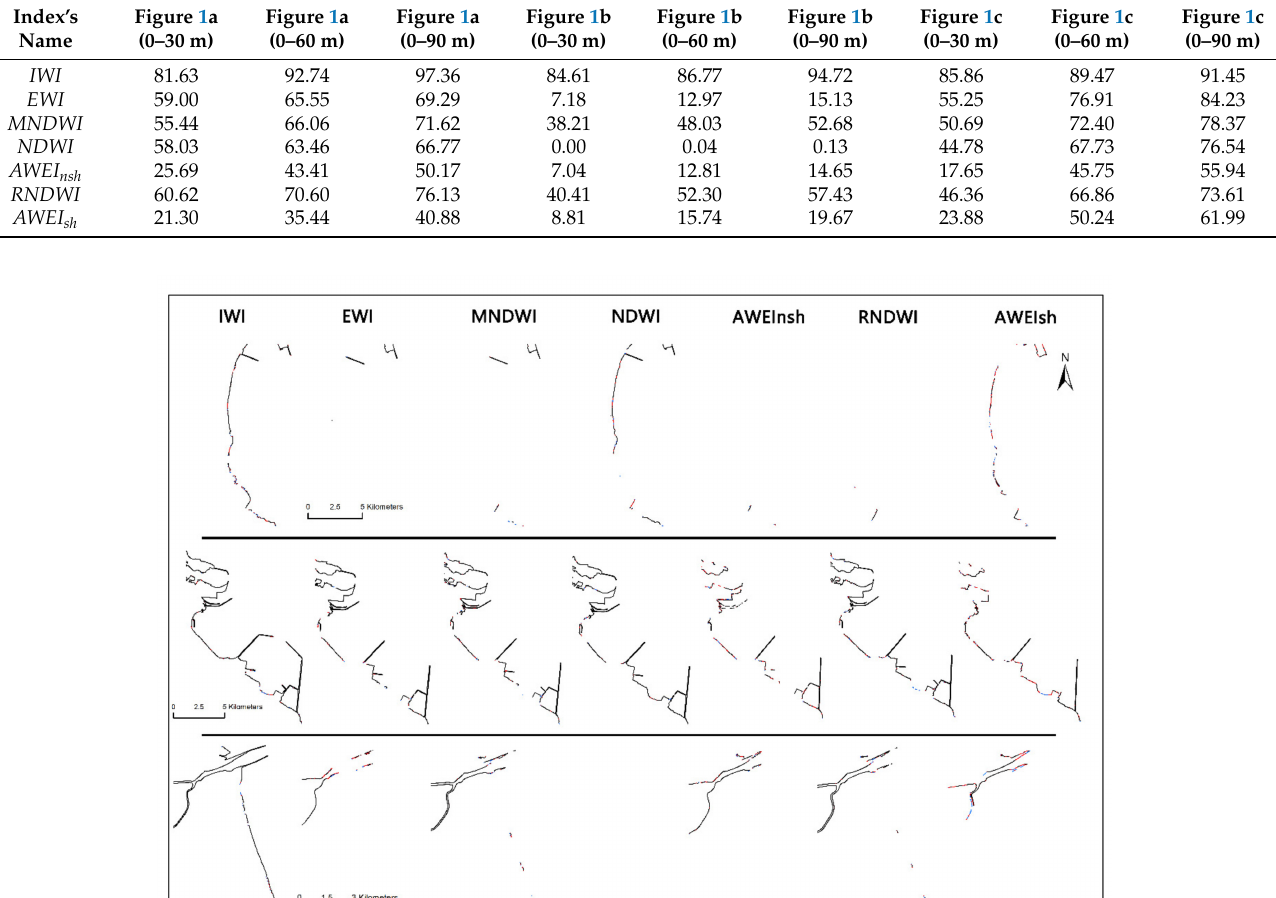
Table 5. Accuracy analysis of the coastline results (%) for different indices.